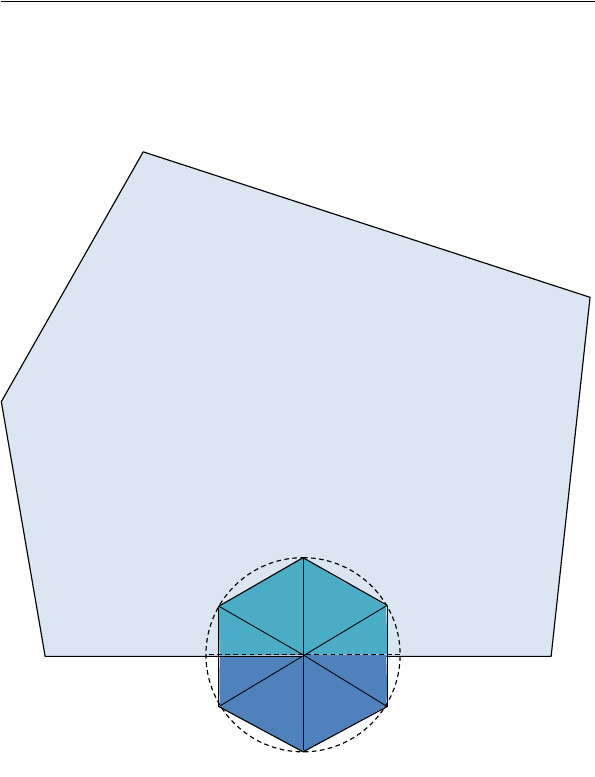
Figure 26: Bending failure polygon subtraction from a relatively large floe.